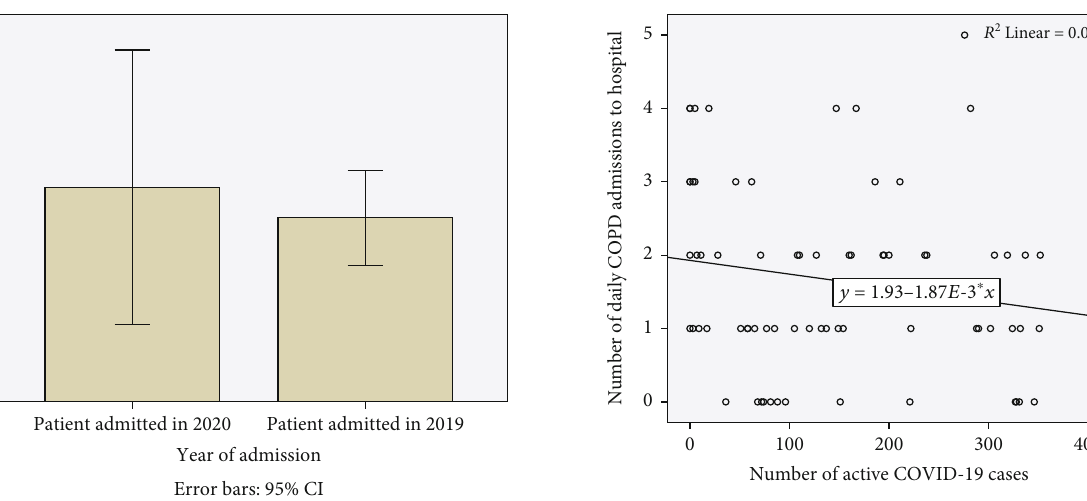
Figure 1: Graph showing the mean time between onsets of symptoms prior to presentation in AECOPD hospitalisations in 2019 compared with